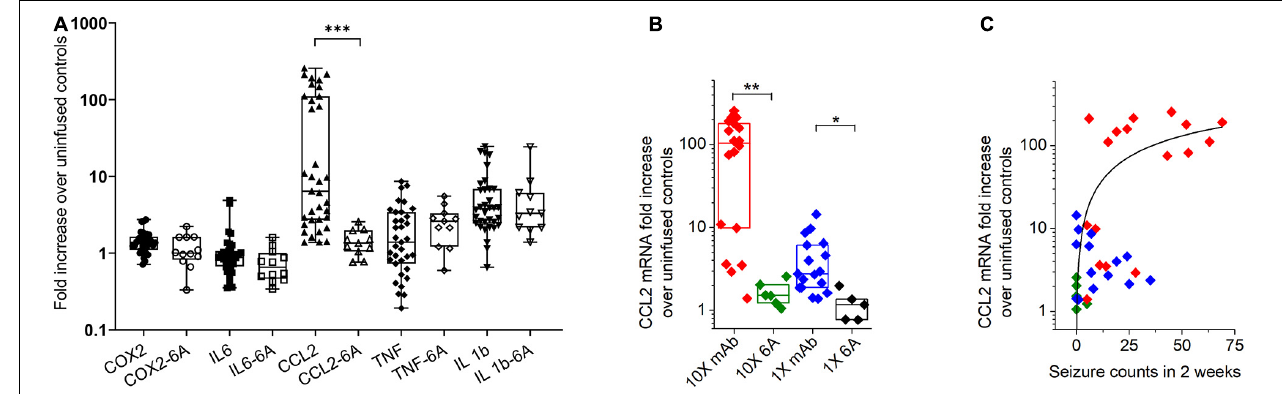
FIGURE 5 | Expression of inflammatory mediators in the hippocampus of mice with antibody-induced seizures. (A) C-C chemokine ligand 2 (CCL2) mRNA level was increased in mice that developed seizures during the infusion of antibodies. Data are median fold change in mRNA expression (horizontal bars) in mice treated with 1X and 10X concentrations of 5F5, 2G6 and 3C11 antibody protein (closed symbols) or 6A control IgG protein (open symbols), relative to the corresponding values in mice that were not infused with antibodies. N = 34–36 (5F5, 2G6 and 3C11 antibodies), n = 11–12 (6A antibodies). The boxes are interquartile ranges (IQR, 25–75%), the whiskers are the minimum and maximum values. *** p < 0.001, Kruskal-Wallis test with Dunn’s multiple comparison tests. COX-2, cyclooxygenase-2; IL-6, interleukin-6 (IL-6); TNF, tumor necrosis factor (B) The increase of hippocampal CCL2 mRNA was related to 5F5, 2G6, and 3C11 monoclonal antibody protein (mAb) concentration. Data are medians (horizontal bars), 25–75% interquartile ranges (IQR, boxes). Note log scale on Y axis. (C) Increase in CCL2 mRNA expression in hippocampus of mice treated with 10 × 5F5, 2G6 and 3C11 monoclonal antibody protein was related to the number of antibody-induced seizures. 1x: n = 14 (mAb, blue diamonds) and n = 5 (control 6A IgG, black diamonds); 10X: n = 18 (mAB, red diamonds) and n = 6 (control 6A IgG, green diamonds). Note log scale on Y axis. ** p < 0.01, and * p < 0.05, Kruskal-Wallis test with Dunn’s